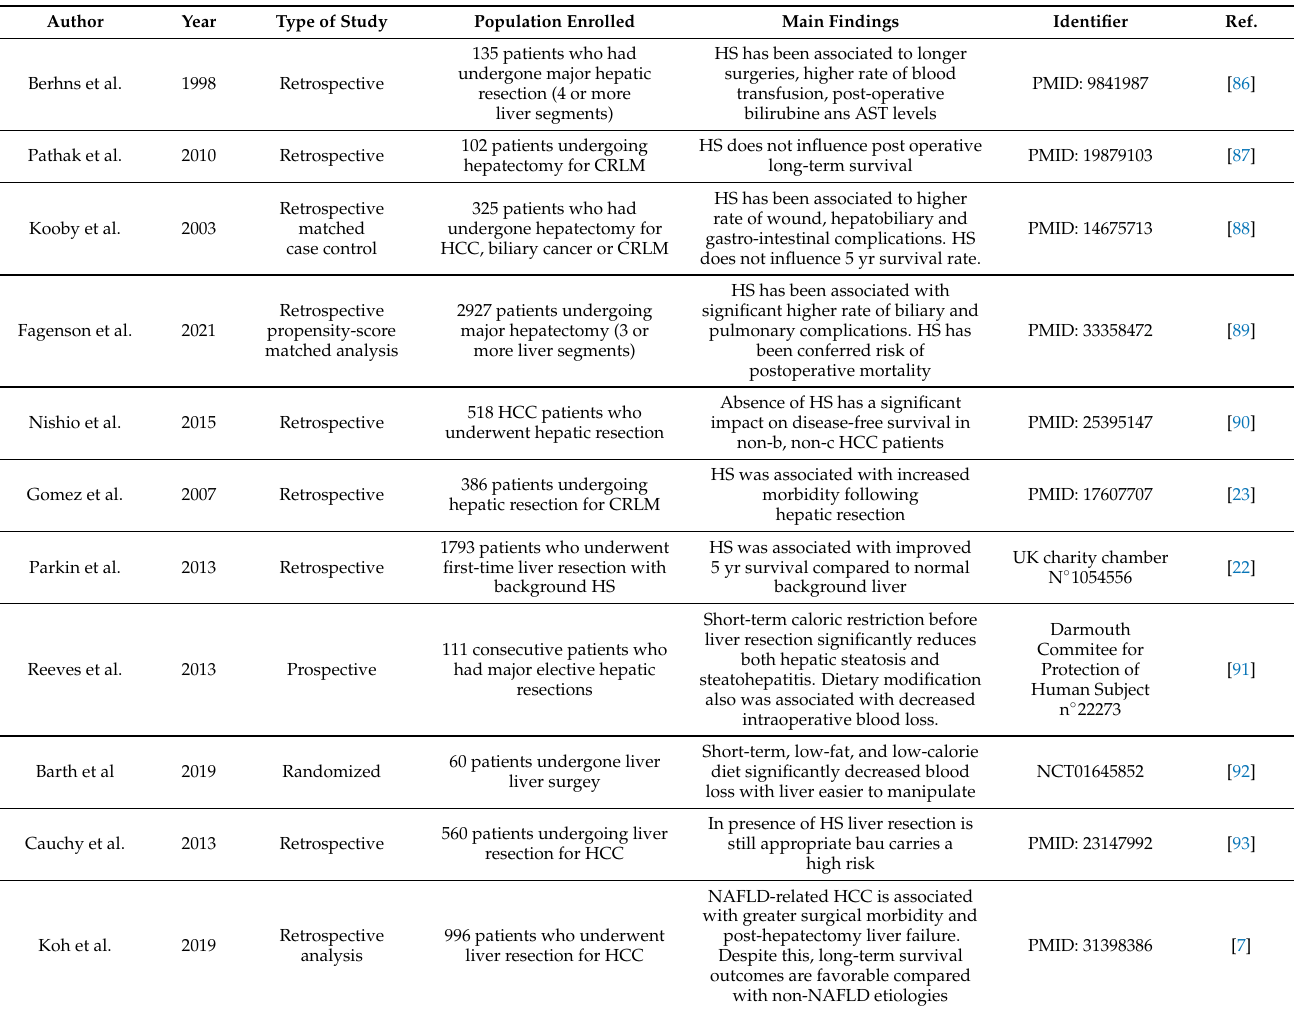
Table 1. Summary of the studies evaluating the impact of HS on liver surgery complications and